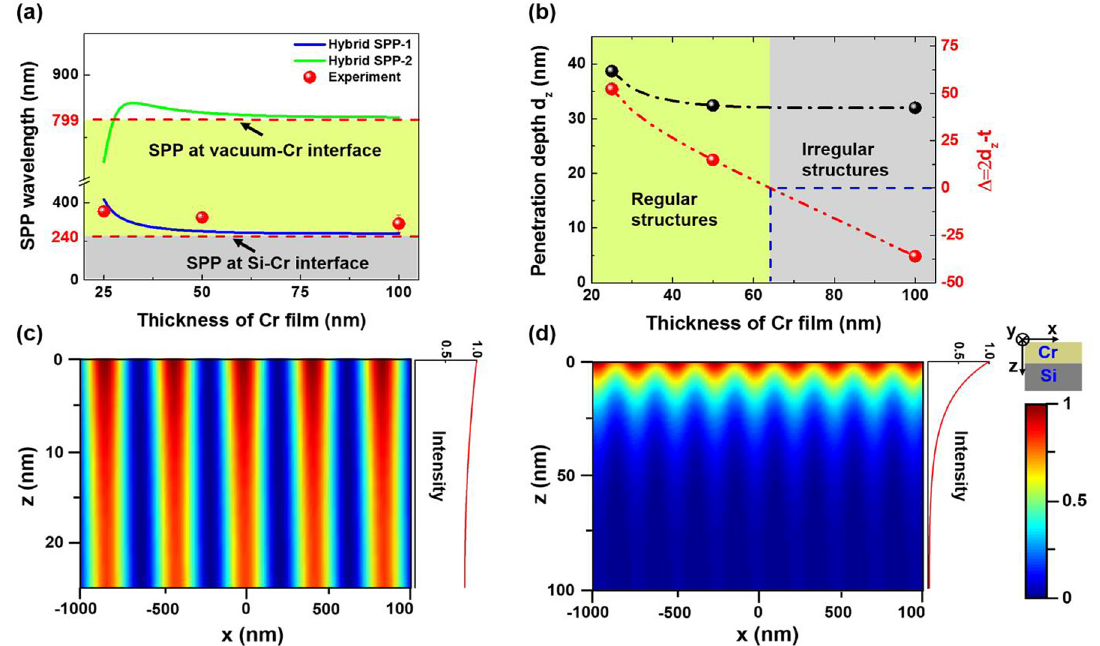
Figure 4: (a) Calculated wavelengths of the hybrid SPP-1 and SPP-2 versus the Cr film thickness. Red solid circles represent the measured period of the laser-induced structures on Cr metal film with different thicknesses. (b) Calculated optical penetration depths d z of the hybrid SPP-1 mode in Cr fi lm (black color), and the values of Δ = 2 d z − t (red color) as a function of the Cr fi lm thickness t . The latter can be used for identifying the regular formation of the laser-induced structures. Simulations of spatially periodic intensity patterns from interference between the incident laser and the excited hybrid SPP-1 mode in Cr fi lms with different thicknesses: (c) 25 nm (d) 100 nm. The red curves on the right panels represent the retrieved intensity decaying situations along the film depth